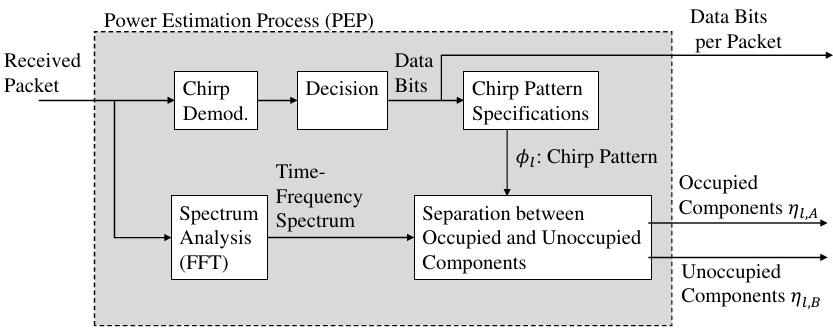
Figure 4. System flow of the power estimation process (PEP) in the proposed estimation